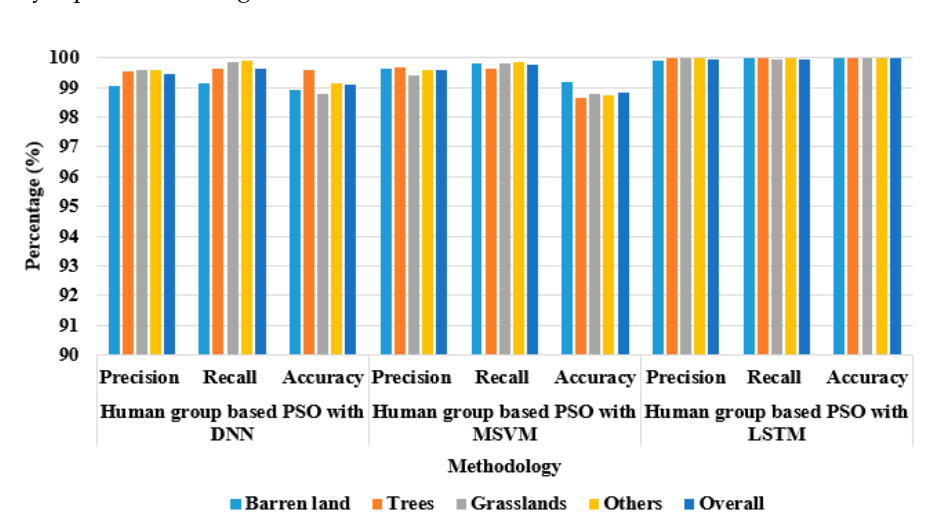
Figure 8. Graphical investigation of the proposed model with different classifiers on Sat 4 dataset.